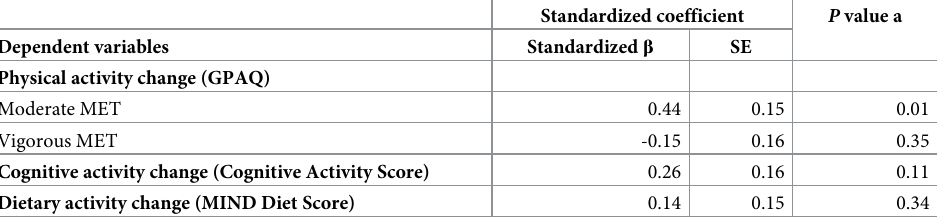
Table 2. Multiple linear regression analysis for associations of motivational enhancement smartphone application with behavioral changes on brain health activities.